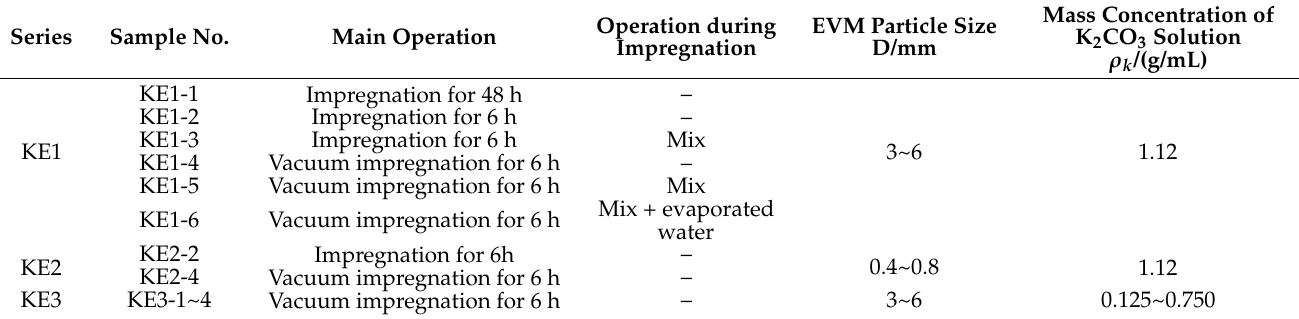
Table 1. The main operation and formula of composite materials.